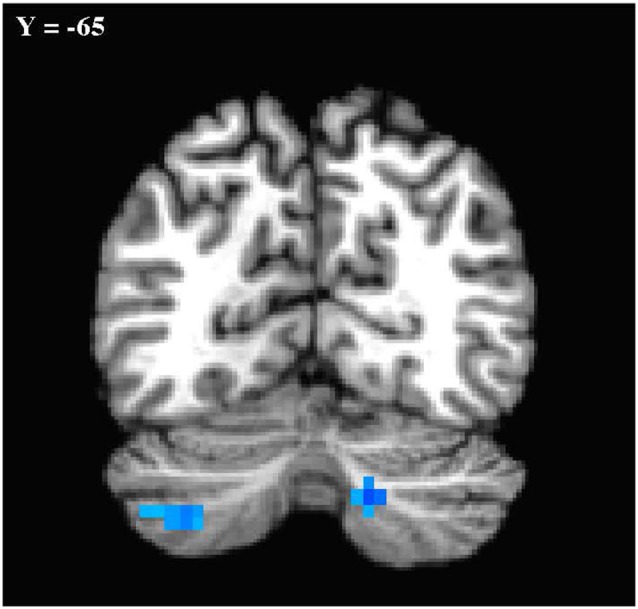
Cerebellar clusters exhibiting a diagnosis-by-sex interaction. Shown in standard Talairach Tournoux space. Left is shown on the left. Mode contrast = autism spectrum disorder (ASD males—ASD Females) × typically developing (TD males—TD females). Clusters shown were significant at p < 0.05 with small volume correction for the cerebellum.